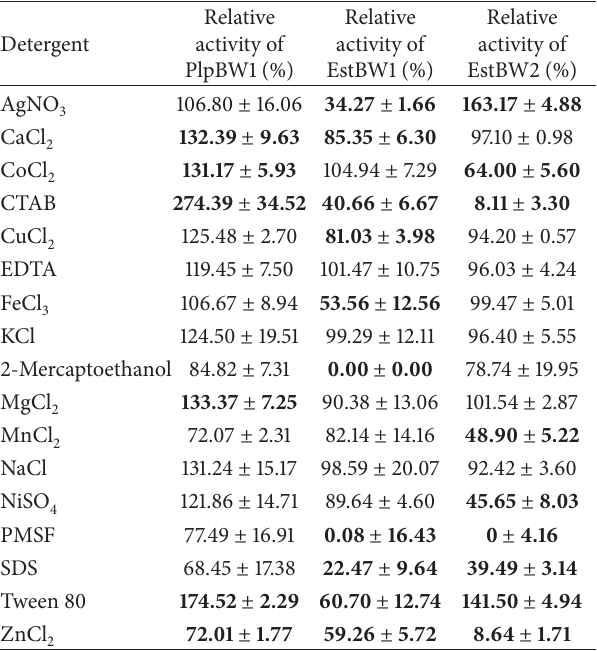
Table 4: Relative activities of recombinant esterases in the presence of different chemical compounds. The effect of the additives was further tested for significance. Significant effects ( 𝑃 < 0.05 ) are written in bold